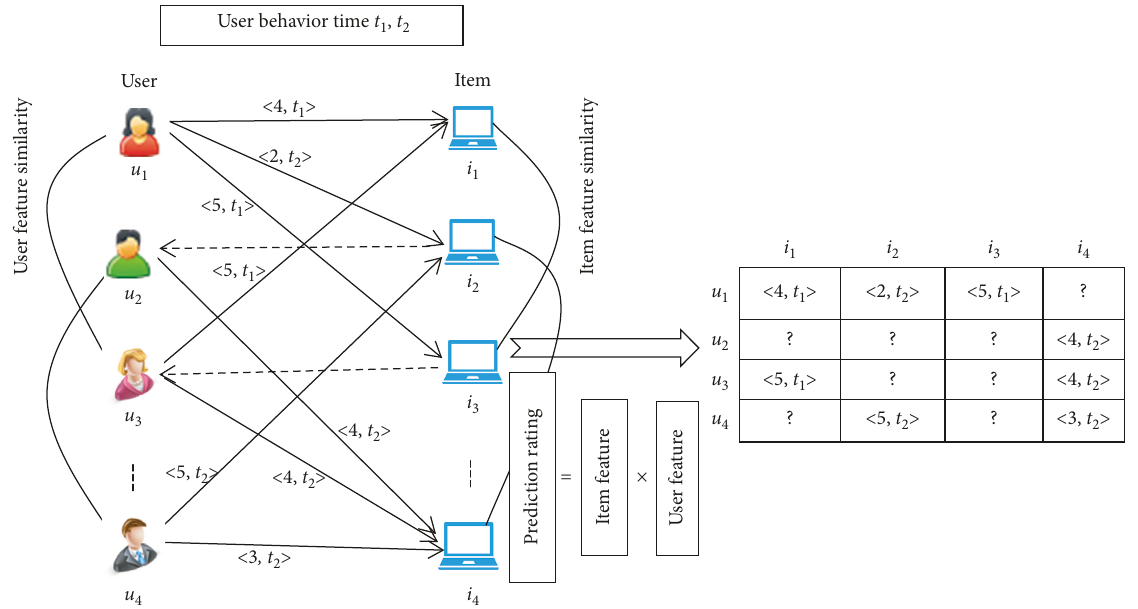
Figure 2: The framework of time-aware CNN-based personalized recommender system